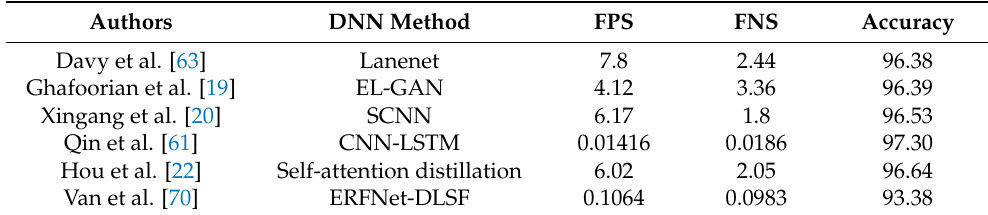
Table 3. Summary of lane detection techniques using